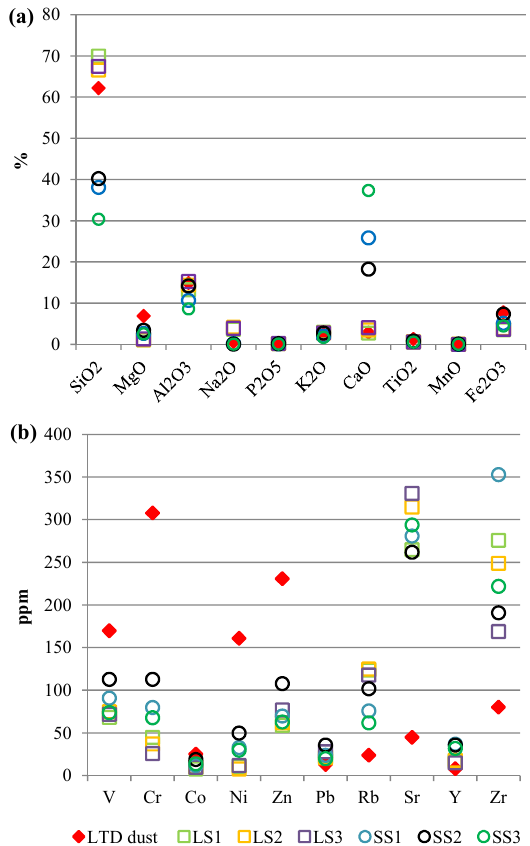
Fig. 7. (a) Chemical analysis of major elements (%) and (b) trace elements (ppm) in the LTD dust sample from the Garabashi Glacier compared to local sediments (LS) and the Saharan soils from the source region (SS), derived from XRF analysis. Data for copper and analyses of GSP-1 and DRN standards are presented in the Supple-